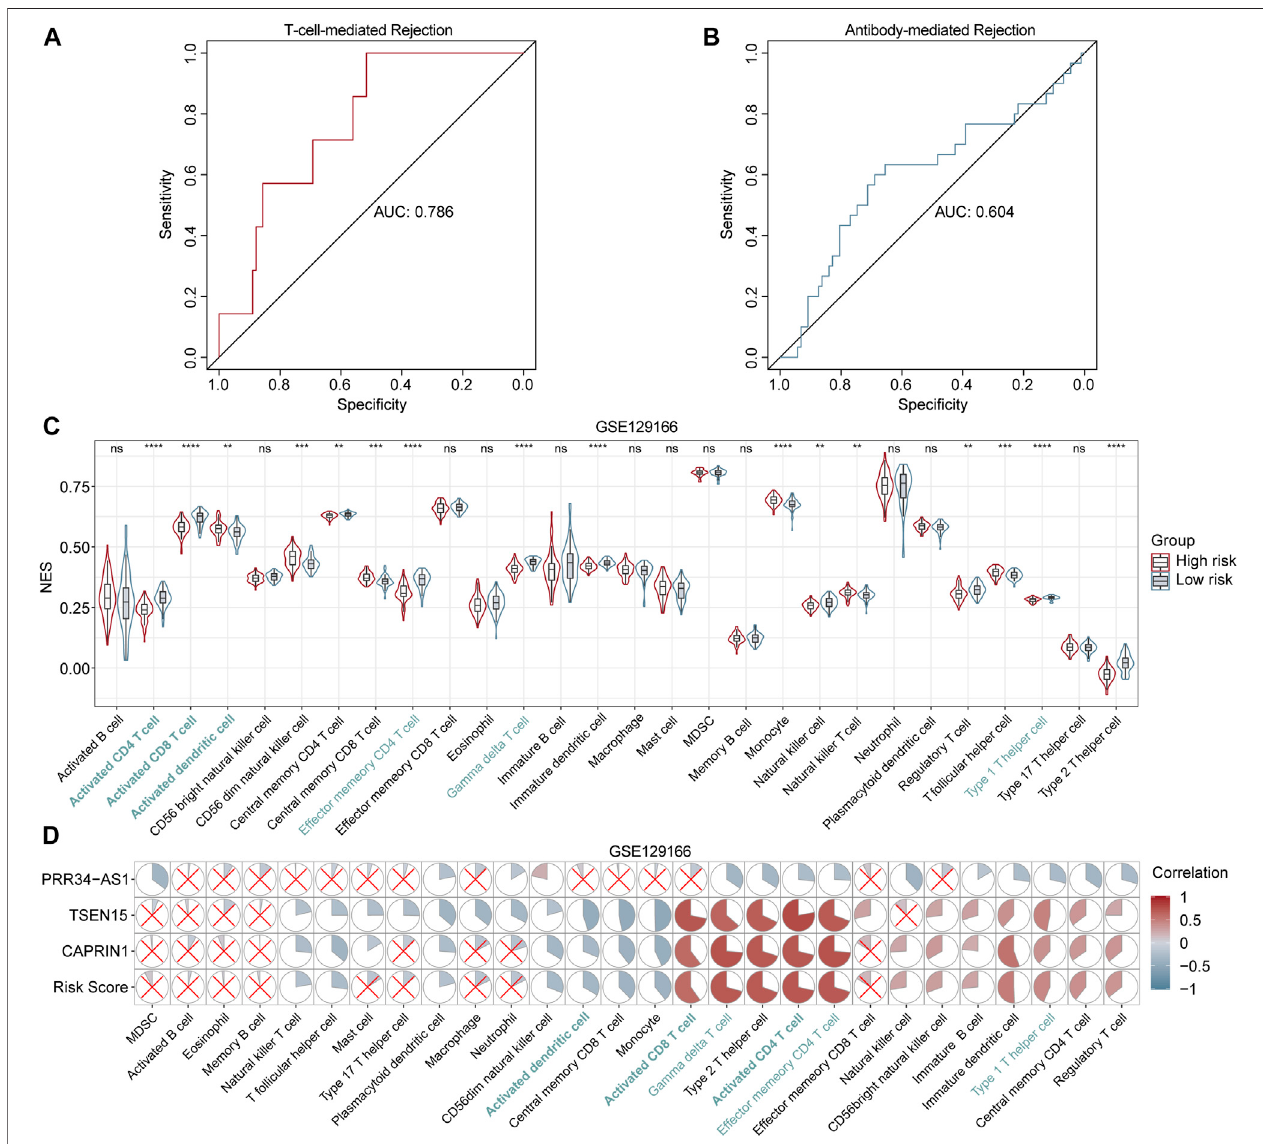
FIGURE 6 | PerformanceofthediagnosticmodelindistinguishingTCMRandABMR (AandB) ROCcurvesforTCMRandABMRdiagnosisinGSE129166 (C) Violinand boxplotsshowthedifferencesinimmunecellsbetweenhigh-andlow-riskpatientsinGSE129166.Commoncellswithdifferentlevelsbetweentworiskclassesinallthreecohorts (GSE15296,GSE14346andGSE129166)arelabeledinblue.* p < 0.05;** p < 0.01;*** p < 0.001;**** p < 0.0001;ns,notstatisticallysigni fi cant (D) Correlationheatmapsbetween theimmunecelllevelsandexpressionlevelsofthreegenesinGSE129166.Redandbluecirclesrepresentpositiveandnegativecorrelations,respectively.Largertosmaller pie fi ll area indicates high to low correlation, no statistically signi fi cant correlations ( p > 0.05) are represented by red crosses.